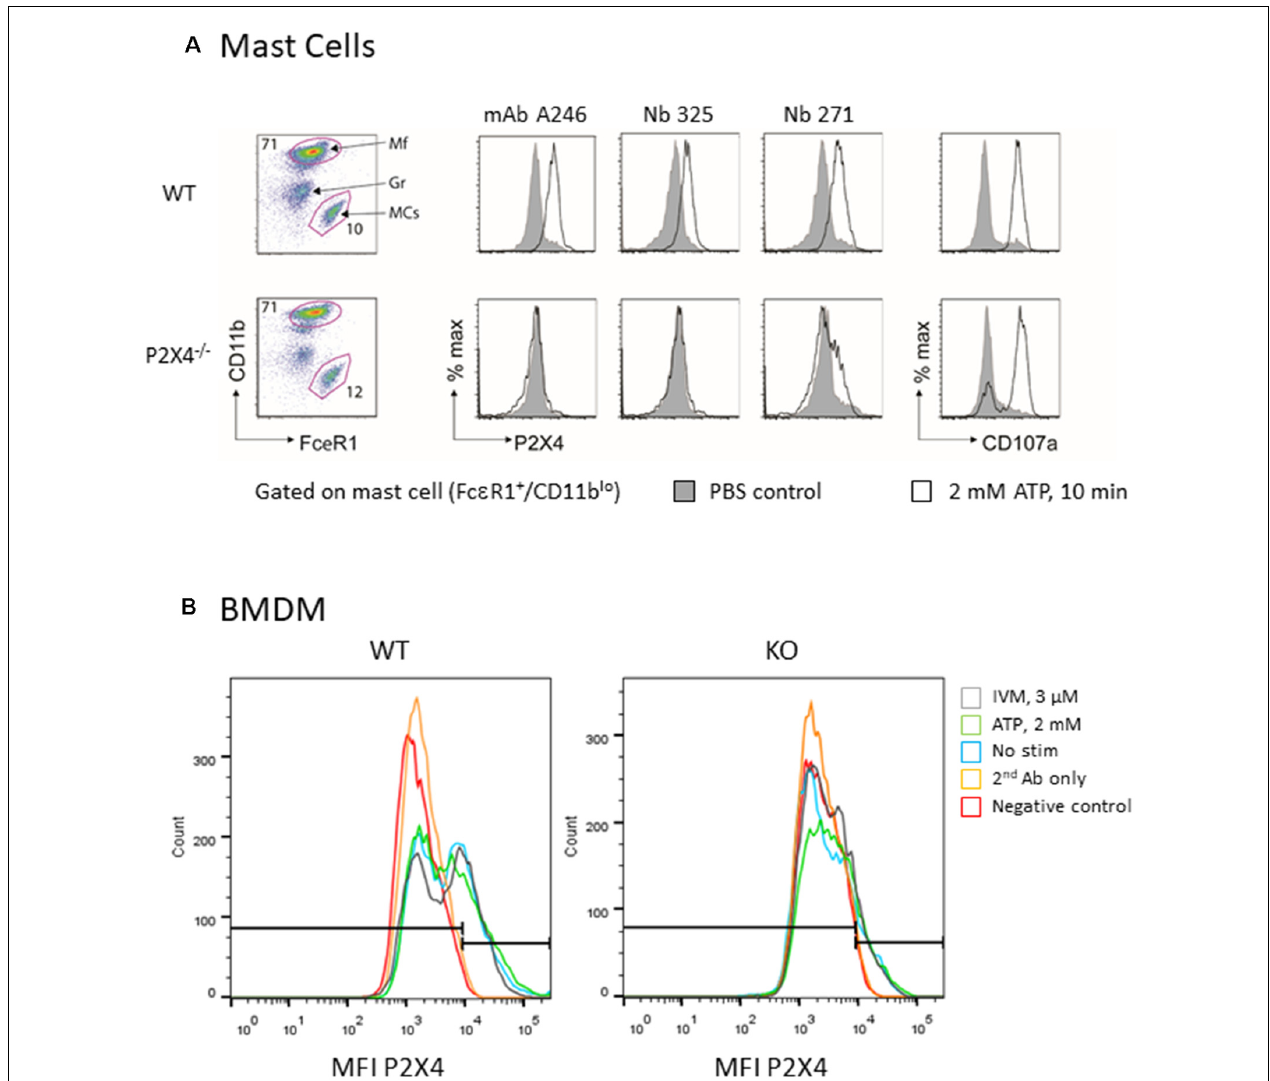
FIGURE 6 | Flow cytometry analysis of native mouse P2X4 expressed by peritoneal mast cells and BMDM. (A) Peritoneal cells from WT and P2X4 − / − were stimulated (white) or not (gray) for 10 min with 2 mM ATP at 37 ◦ C. Cells were washed and incubated at 4 ◦ C with anti-CD11b-PerCO and anti-Fc ε R1-PE as well as with various antibodies directed against P2X4 and appropriate secondary antibodies (AF647 or AF488). CD107a (LAMP1-FITC) was used as a control experiment. Mast cells were identified as CD11b low, Fc ε R1+. mAb Nodu 246: rat monoclonal antibody; Nb 325, Nb 271: Nanobodies. (B) Similar flow cytometry experiments of WT and P2X4 − / − BMDM using Nb 271 RbhcAb. Cells were stimulated as above with 2 mM ATP (ATP, green), 3 µ M ivermectin (IVM, gray), or not stimulated (nanobody, blue). Negative controls were secondary antibody only (secondary antibody, orange) and unlabeled cells (Neg,